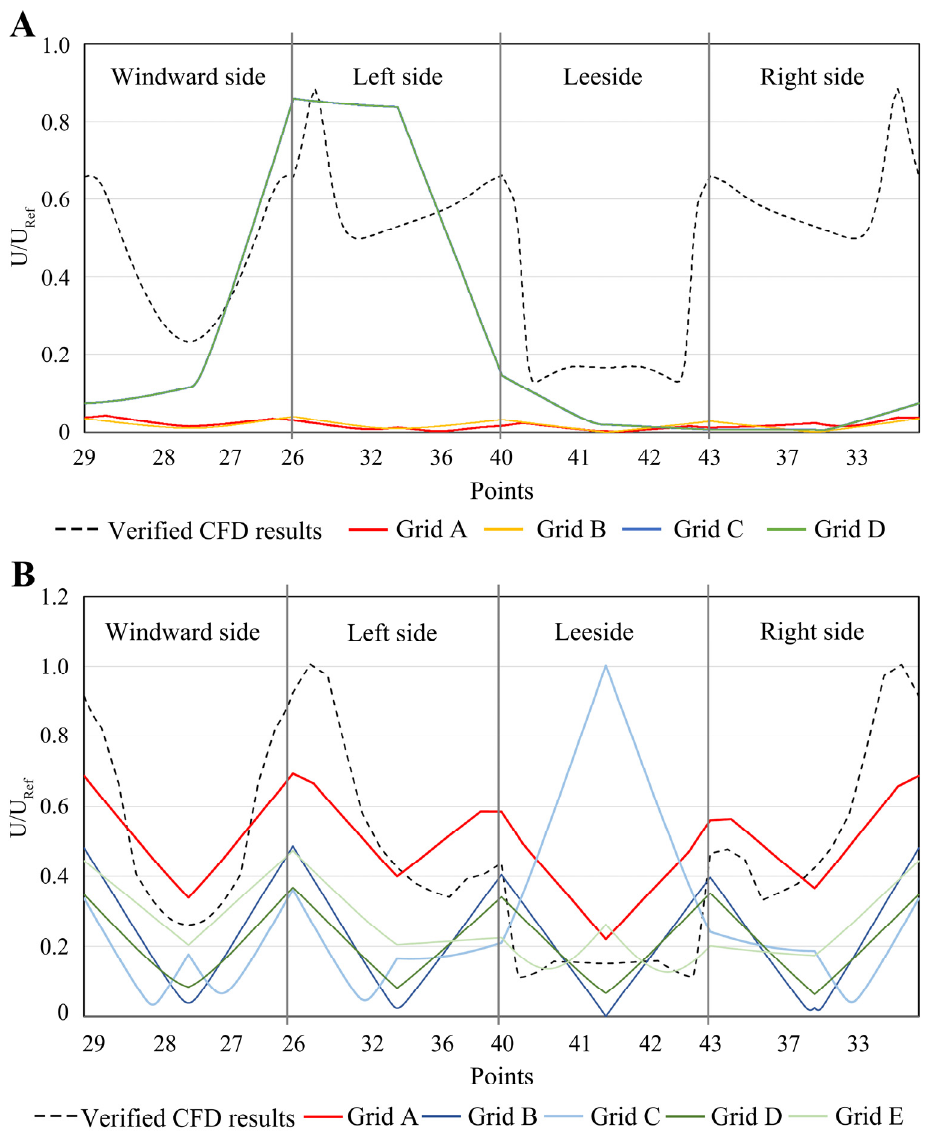
Figure 7. Comparison of wind speed ratio between different grid schemes on measurement points of horizontal planes at ( A ) pedestrian level and ( B ) 90 m height corresponding to 0 ◦ wind direction. (The reference wind velocity U ref is 6.65 m/s).